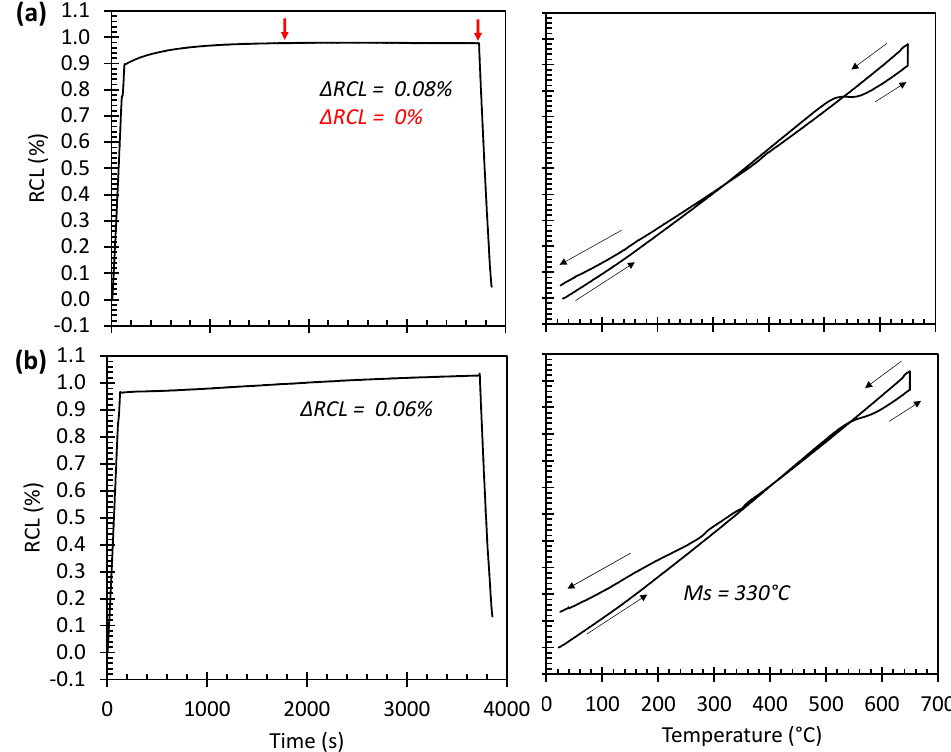
Figure 9. Relative change in length (RCL) as a function of time and temperature for ( a ) 06CV and ( b ) 06C1MoV steel tempered at 650 °C.